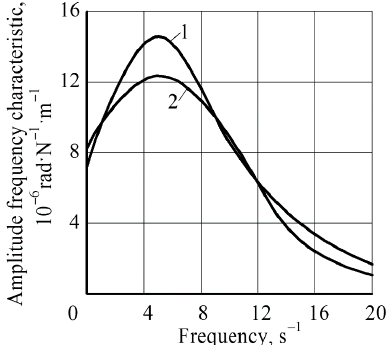
Figure 8. The amplitude–frequency characteristic of angle ϕ during the processing of the disturbing impact at different values of speed V o : 1—1 m ∙ s − 1 ; 2—3 m ∙ s − 1 .